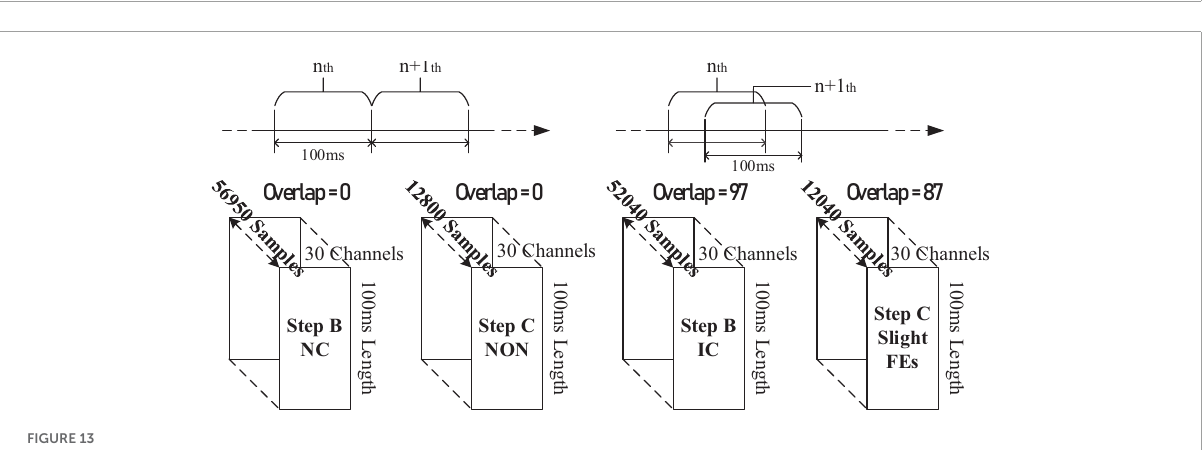
FIGURE13 The illustration for datasets in offline